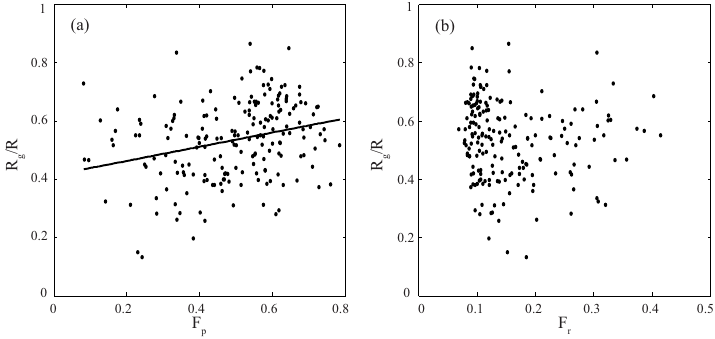
Fig. 7. Scatter plots of the ratio of subsurface runoff to total runoff ( R g /R ) againt (a) persistent fPAR ( F p , represents woody vegetation cover) and (b) recurrent fPAR ( F r , represents non-woody vegetation